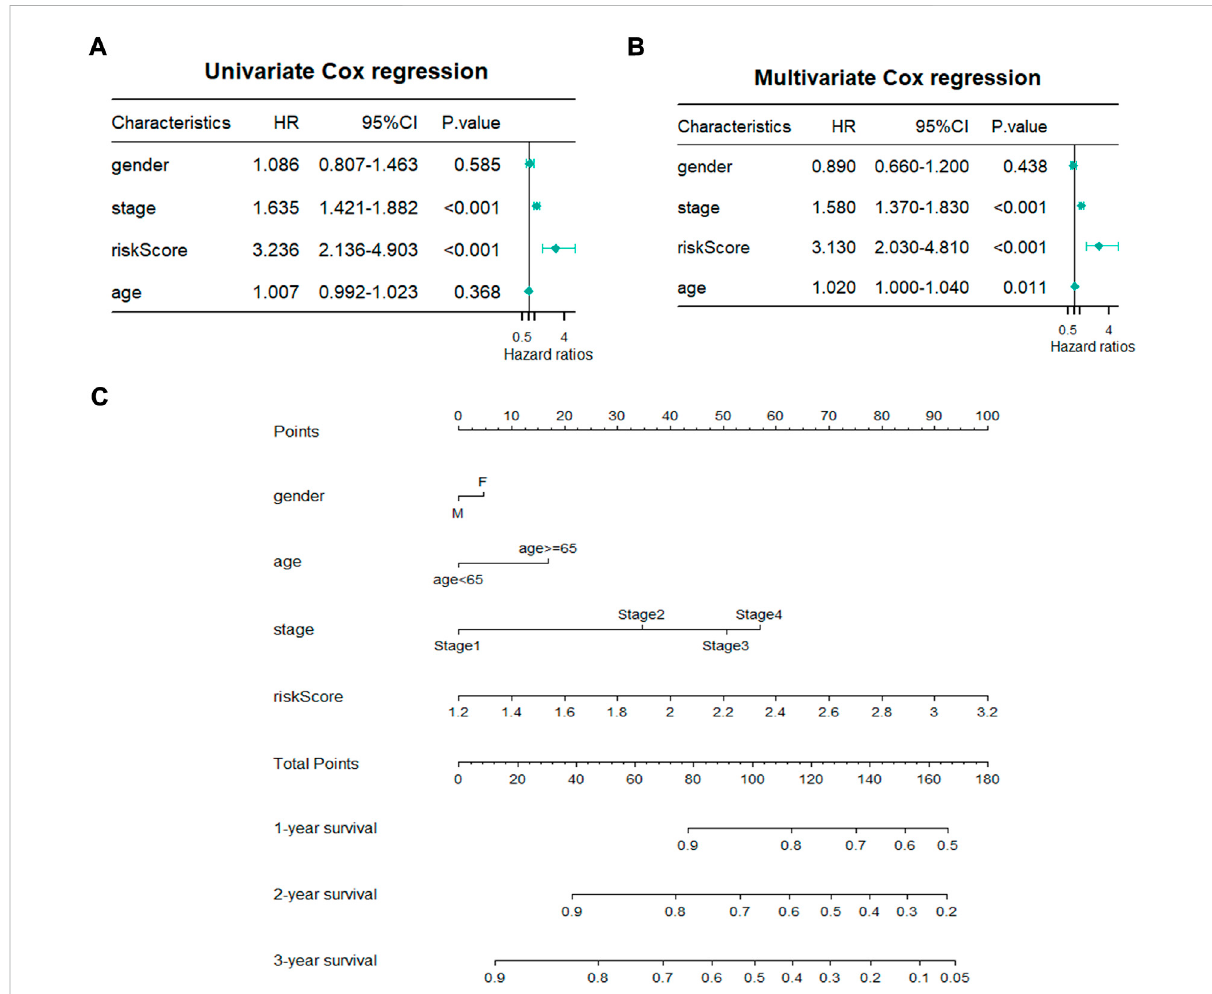
FIGURE 5 Establishment of prognostic nomogram. (A,B) Univariate and Multivariate Cox regression analyses of clinicopathological parameters with overall survival. (C) A novel prognostic nomogram based on gender, pathological stage, risk score and